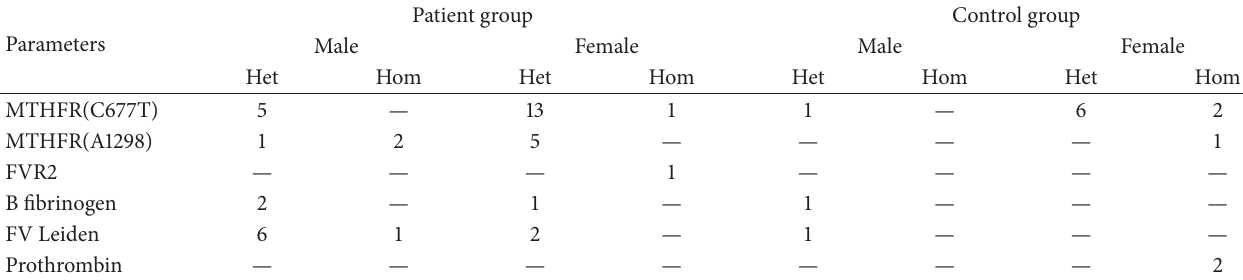
Table 4: The comparison of point mutations in the study group and control group.